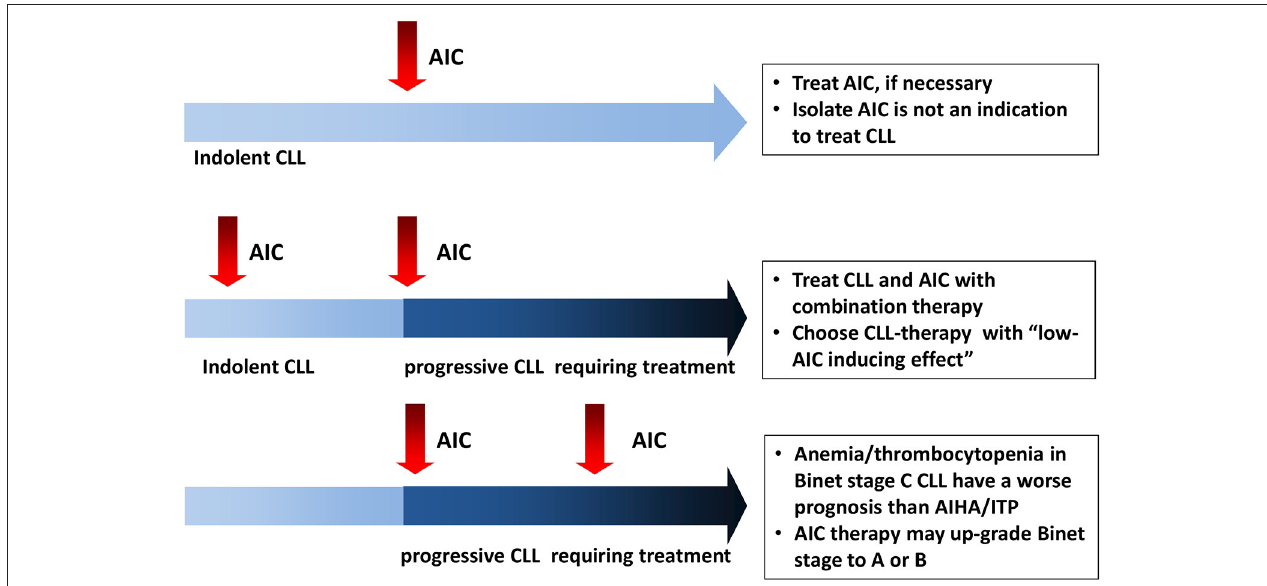
FIGURE 1 | Autoimmune cytopenias (AIC) in chronic lymphocytic leukemia (CLL): the heterogeneity of onset imposes different management in each